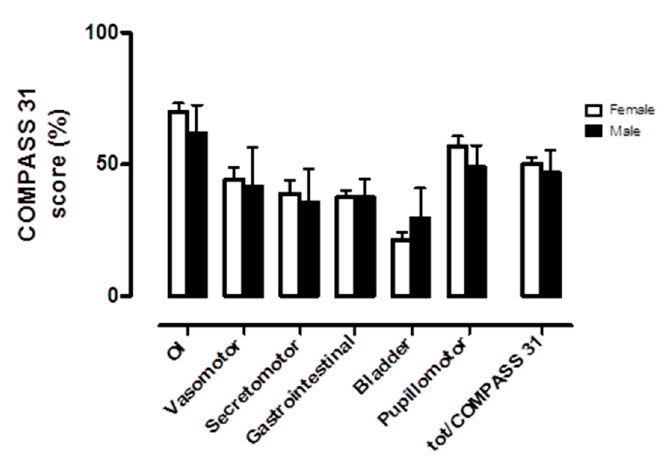
Figure 3. Baseline autonomic symptom assessment by COMPASS 31 according to gender. OI indicates orthostatic intolerance domain; Vasomotor, vasomotor function domain; Secretomotor, secretomotor Table 4. function domain; Gastrointestinal, gastrointestinal function domain; Bladder, bladder function domain; Pupillomotor, pupillomotor function domain; tot / COMPASS 31, total COMPASS 31 score. The scores Table 4. COMPASS 31 weighted scores at baseline according to gender. are here represented as a percentage of the maximum value obtainable in each